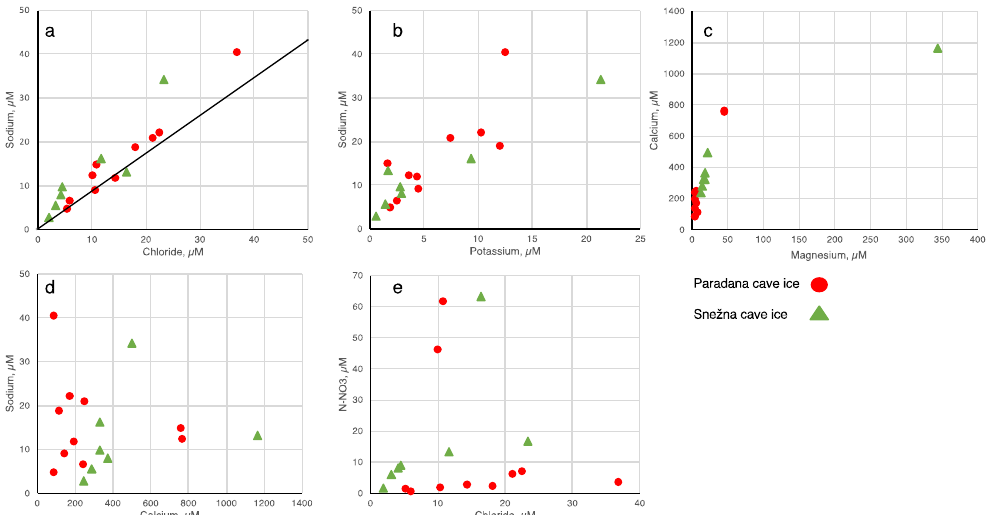
Figure 4. Scatter plots of major ions in cave ice. The Paradana ice samples are shown as red circles and the Snežna ice samples are shown as green triangles. In a, the line shown is the Na:Cl ratio for seawater. ( a ) sodium versus chloride, ( b ) sodium versus potassium, ( c ) calcium versus magnesium, ( d ) sodium versus calcium, ( e ) nitrate versus chloride.